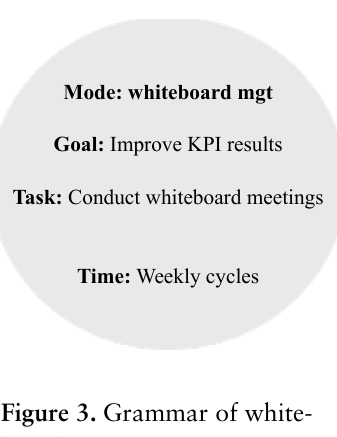
Figure 3. Grammar of